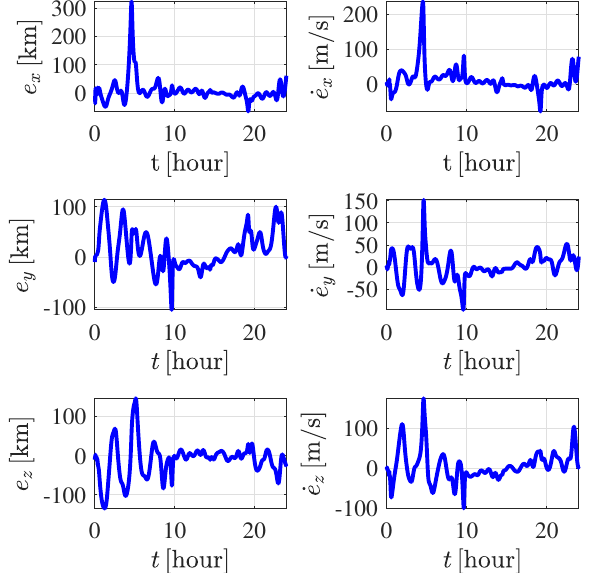
Figure 6. OD results without using the polynomials. The blue lines represent the estimated errors. It can be seen that the case without using polynomials has the largest estimated errors, with the position errors larger than 300 km and the velocity larger than 200 m/s. For case using the zeroth-order polynomials and the first-order polynomials, the unknown maneuvers are not approximated accurately and their navigation performances are poor. As shown in Figures 7 and 8, the position estimated errors are around 50 km.